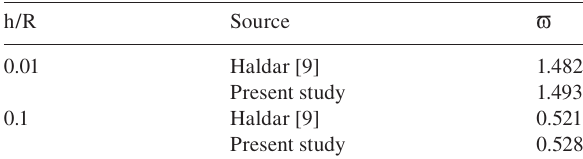
symmetric cross ply (0 ° /90 ° /00 ° ) skewed cantilever cylindrical panel